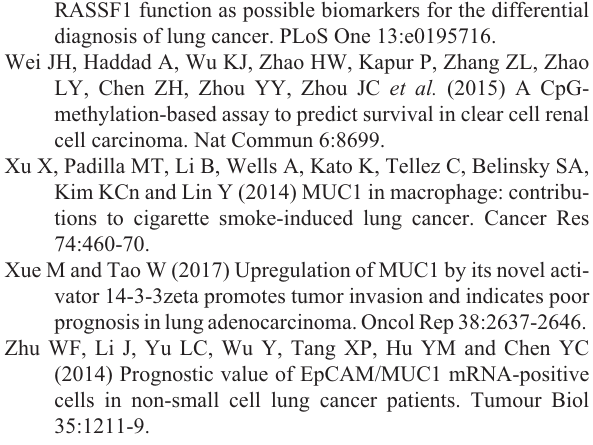
Figure S1 - Kaplan Meier curves of the five-genes-based classifier between high-risk and low-risk groups stratified by clinical variables (sex, age, and pathologic stage). Figure S2 - Other functional epigenetic modules identified in the TCGA dataset (ADCY8, CAOLEC10 and WNT3A) and the validation data set (GSTMS and OTX1). Figure S3 - Illustration of differentially variable and differ- entially methylated CpGs (DVMCs) for the three diagnostic markers in the TCGA LUAD dataset. Table S1 - Table of cox proportional hazards model result for the selected five genes used to construct the prognostic model. Table S2 - Information for the members of MUC1 modules identified in the TCGA and independent validation